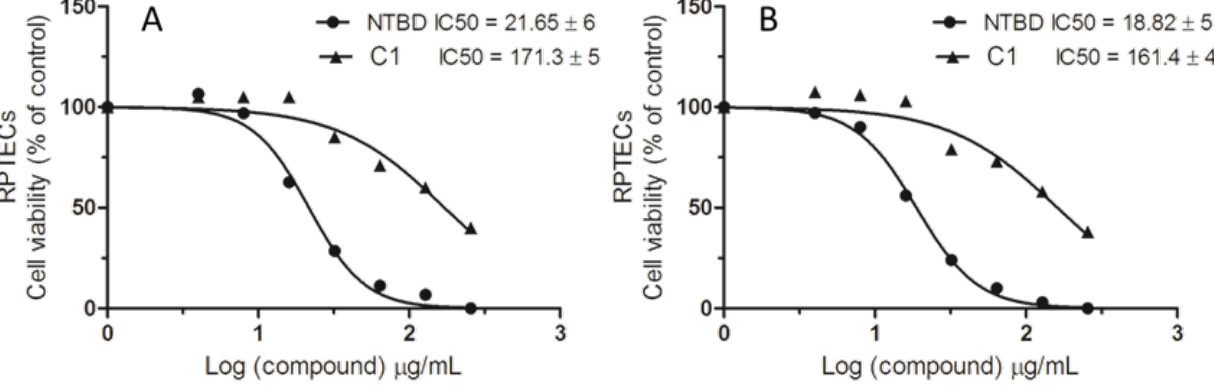
Figure 11. Fitting of drug dose-response curve to yield half-maximal inhibitory concentration. The cells were treated with C1 and NTBD (0–256 µg/mL) for 24 h ( A ) and 48 h ( B ) and MTT assay was performed. The IC50 value was estimated by non-linear regression analysis.